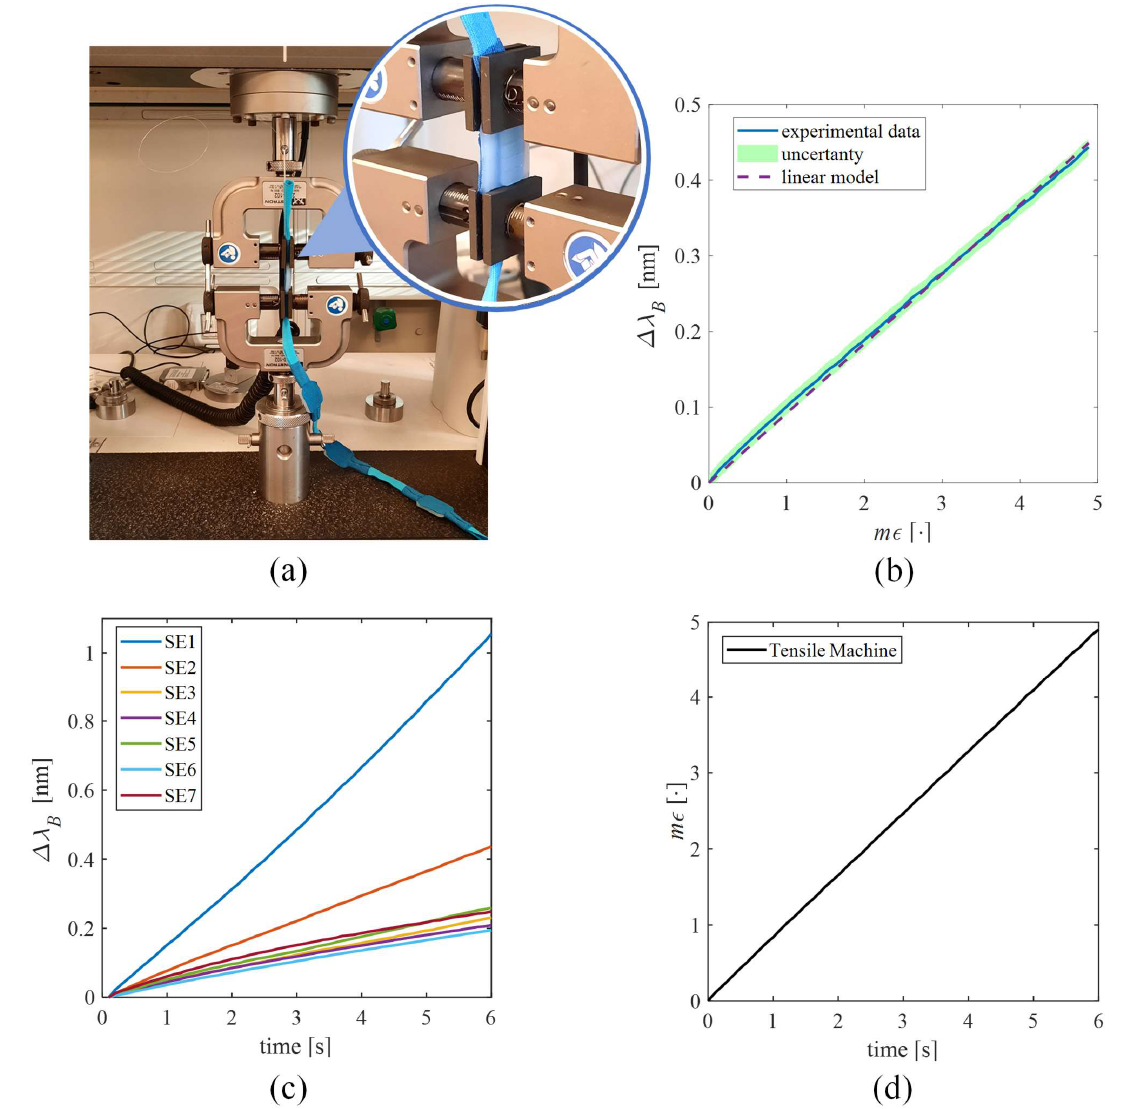
Figure 3. Response to strain of the SSEs. ( a ) The testing machine and a zoom of the sensing element placed between the two clampers. ( b ) The calibration curve of ∆ λ B vs. m ε of SSE2, given as an example. The mean experimental ∆ λ B signal is shown by the blue line, the uncertainty is shown by the shadowed green area, and the linear model is shown by the dotted purple line. ( c ) The average ∆ λ B vs. time of all the SSEs. ( d ) The strain vs. time. Table 1. Values of the. S ε obtained for the seven Hz, while the FBGs’ outputs (i.e., Δλ B ) were recorded by an optical interrogator (si255